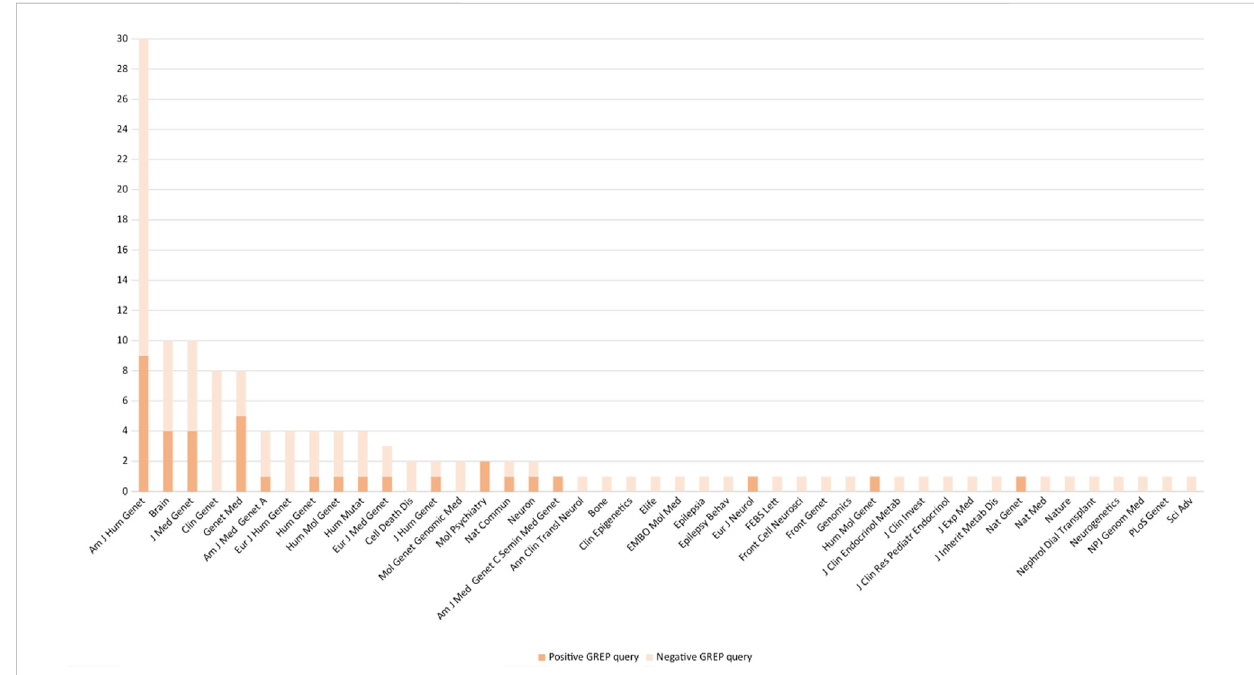
FIGURE 2 Number of positive and negative GREP queries arising from manuscripts published in various journals.